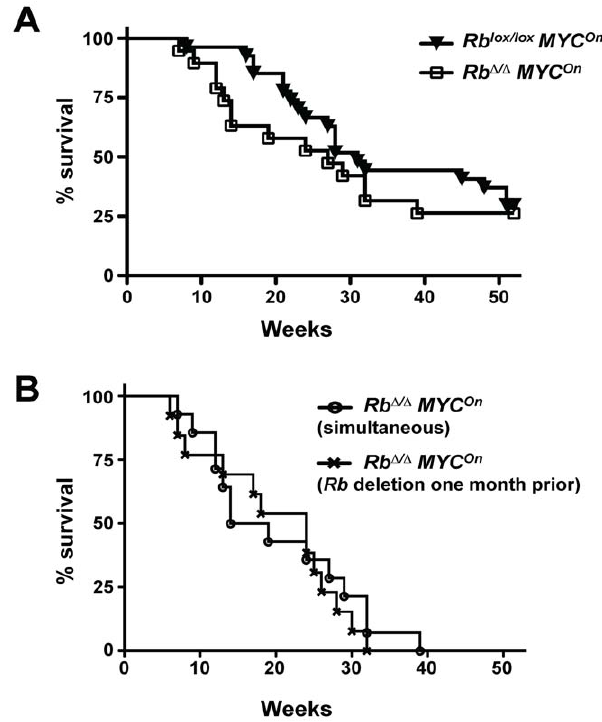
Figure 6. Survival analysis of Myc and Myc/Rb mutant mice. A. Kaplan-Meier survival analysis of MYC (n=27) and MYC/Rb (n=19) mutant mice when both tumorigenic events were triggered simulta- neously (time 0) in adult mice (8–12 weeks after birth) by removal of doxycycline and Ad-Cre infection. B. Survival analysis of MYC/Rb mutant mice developing HCC when both tumorigenic events were triggered simultaneously in adult mice (8–12 weeks after birth) (n=19) and when Rb deletion by Ad-Cre was performed 4 weeks before MYC activation (8–12 weeks and 12–16 weeks after birth, respectively) (n=15); time 0 is the time of MYC activation.